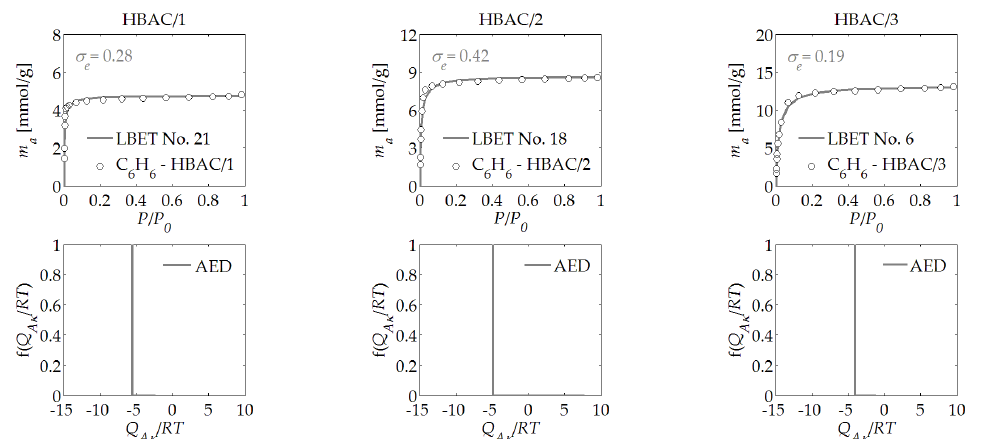
Figure 2. The same as Figure 1, but for the EBAC/ R activated carbon derived from ebony wood.